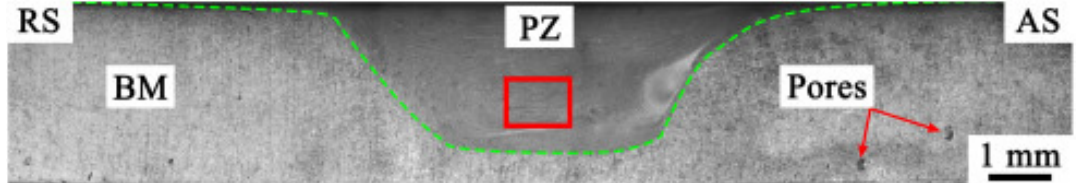
Figure 7. A cross-sectional view of the distribution of pores of SLM 316L where RS is the retreating side, AS is the advancing side, PZ is the processed zone, and BM is the base material. This figure was reprinted with the permission of Peng et al., 2020 [66].